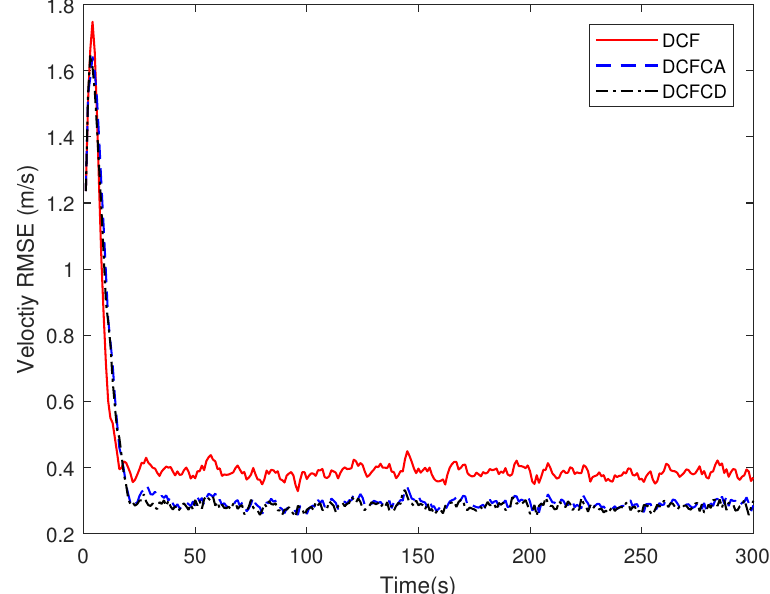
Figure 15. The velocity RMSE for different methods over time with 100 sensor